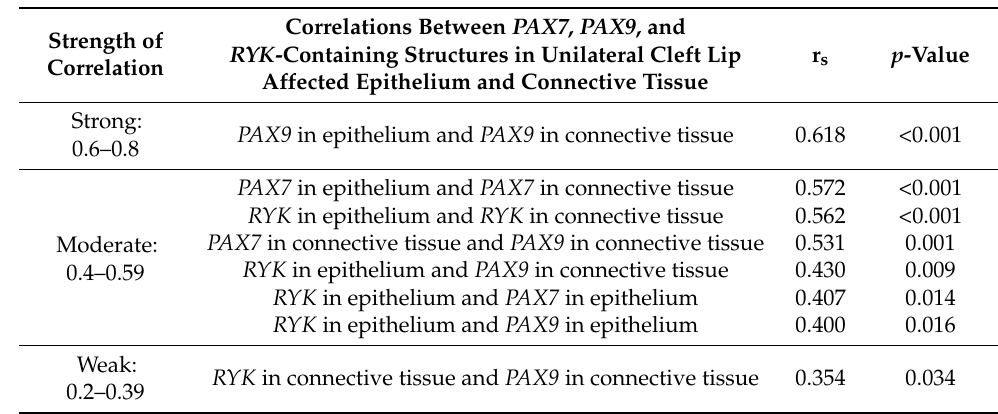
Table 2. Correlations between paired box 7 ( PAX7 ), paired box 9 ( PAX9 ), and receptor-like tyrosine kinase ( RYK ) immunopositive structures in unilateral cleft lip affected tissue based on Spearman’s rank correlation coefficient calculation (r s —Spearman’s rho